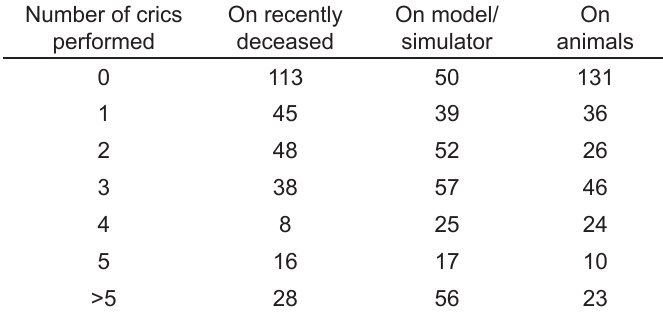
Table 2. Emergency medicine resident experience with cricothyrotomy (crics).